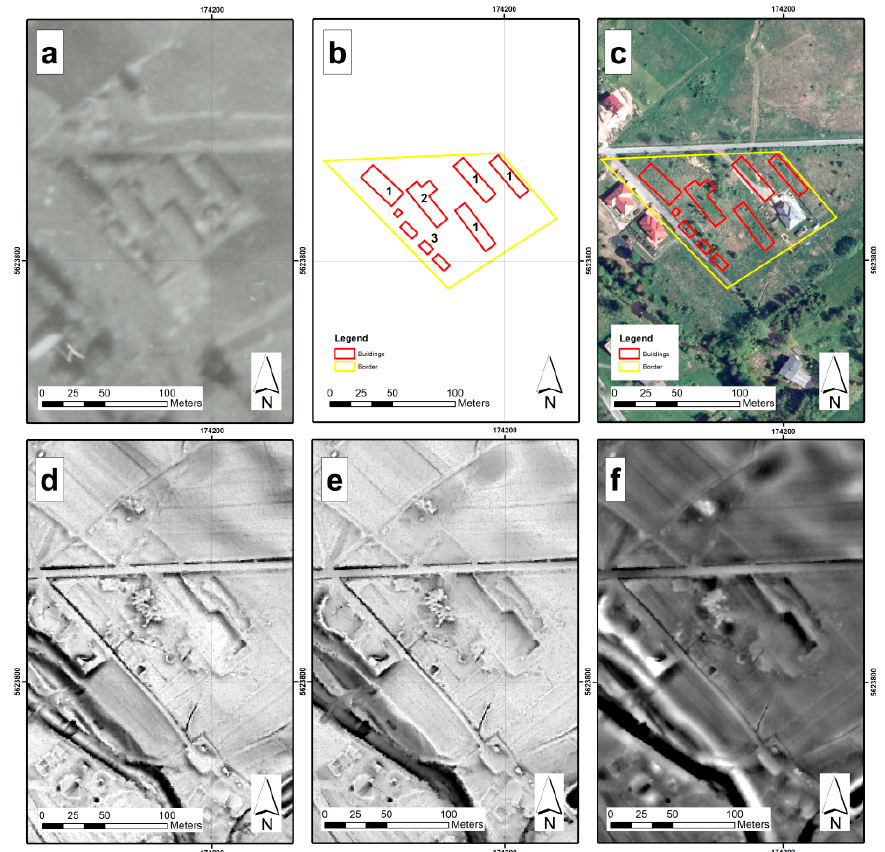
Figure 6. Labour camp AL Kaltwasser: ( a ) ’45 aerial photo (© NARA), ( b ) reconstruction of camp based on ’45 photo: 1 – inmates’ barracks, 2 – kitchen and suspected HQ, 3 – cesspool, ( c ) recent orthophoto of camp area with outlined camp plan (© Head Office of Geodesy and Cartography in Poland), ( d ) SVF image (radius 5m), ( e ) Openness positive image (radius 10m), ( f ) Local Dominance image (min./max.: 10m – 10m). Coordinate grid: UTM Zone 34 N (EPSG: 32634).